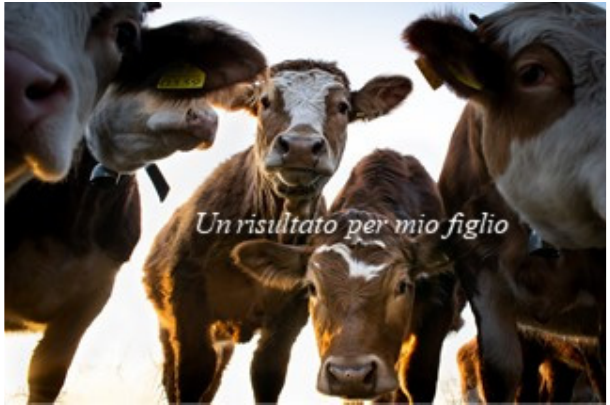
Figure 4. Teresa’s choice of photograph and title: “A product for my son”. Reproduced with permission from www.istockphoto.com (accessed on 29 September 2021).